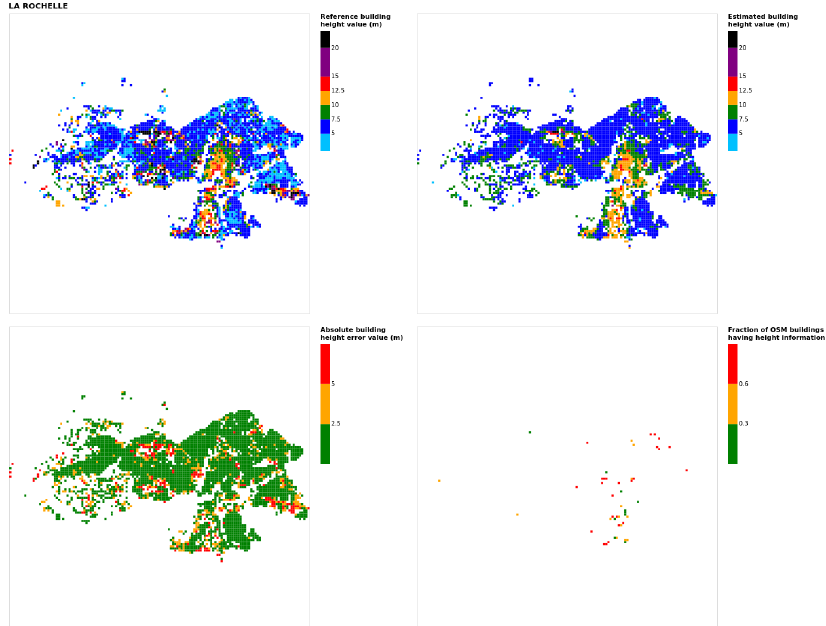
Figure B10. Results for the commune at grid cell (upper left panel) reference building height, (upper right panel) estimated building height, (lower left panel) absolute building height error, and (lower right panel) fraction of OSM buildings that have height information. For all panels except the lower right, only cells that have buildings – with at least 90% of their buildings having no height value in OSM – are